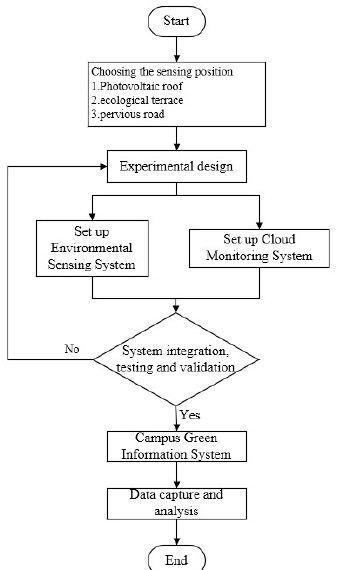
Figure 5. Structure of the cloud management monitoring system.